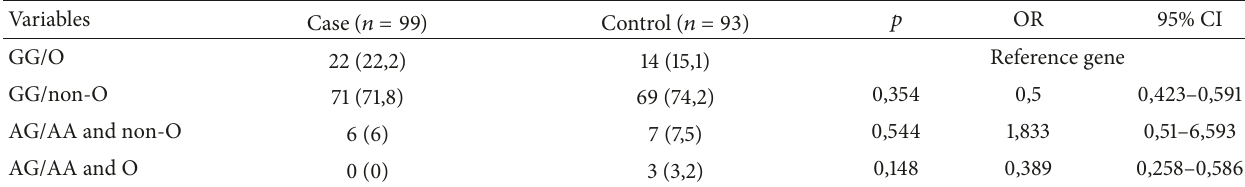
Table 5: Synergistic association between thrombomodulin − 33G > A gene polymorphisms and ABO gene polymorphism with the occurrence of acute myocardial infarct.